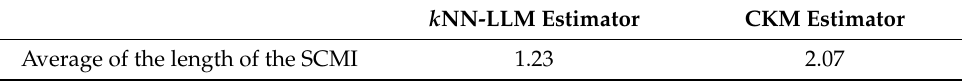
Table 1. The average of the length of the SCMI for k NN-LLM and CKM estimators. k NN-LLM Estimator CKM Estimator Average of the length of the SCMI 1.23